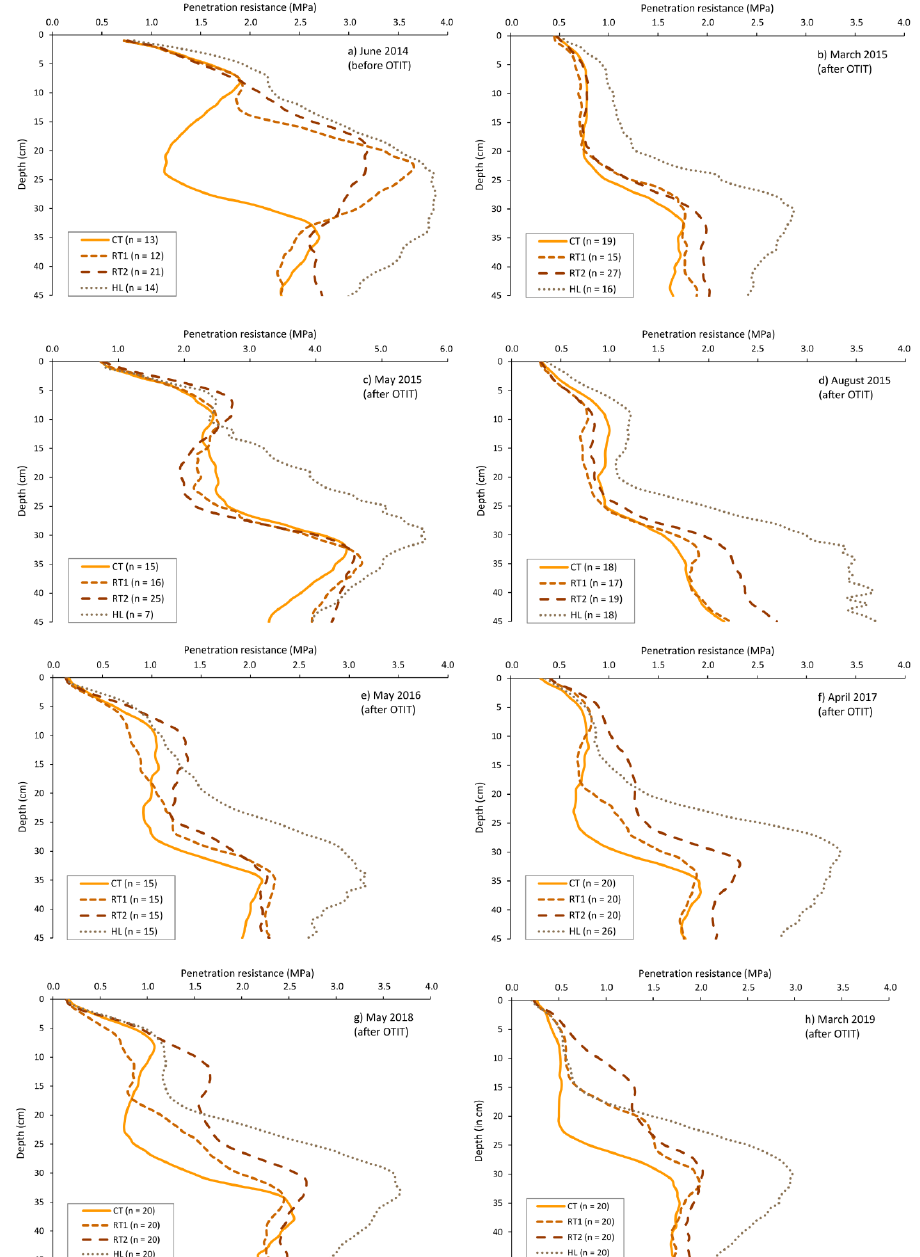
Figure 3. Penetration resistance profiles from 0 to 45 cm depth in 1 cm intervals. For each sampling date ( a – h ), the penetration resistance measurements were averaged for the three former tillage practices (CT: continuously conventional tilled plot, both reduced tilled plots affected by one-time inversion tillage (RT1: chisel plough; RT2: disc harrow). Records in the headlands (HL) were separated from those of the inner field and displayed on an individual graph.